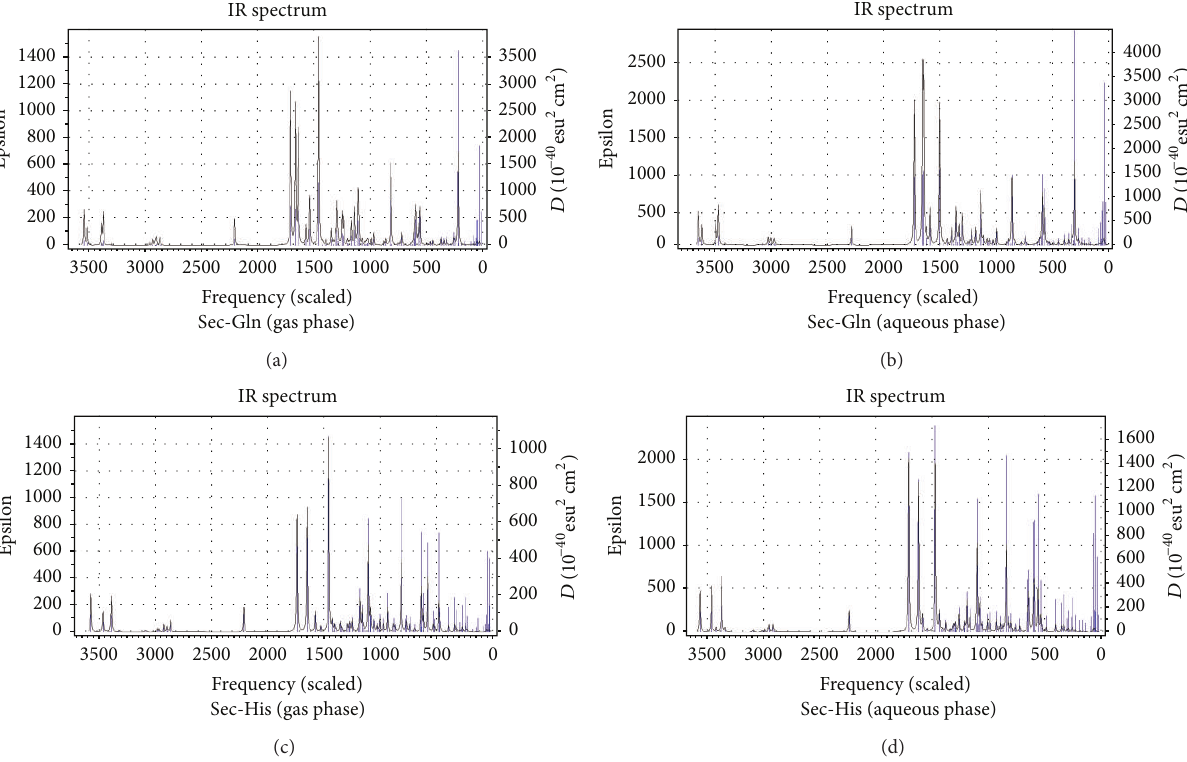
Figure 6: Vibrational spectra of Sec-Gln and Sec-His in gas and aqueous